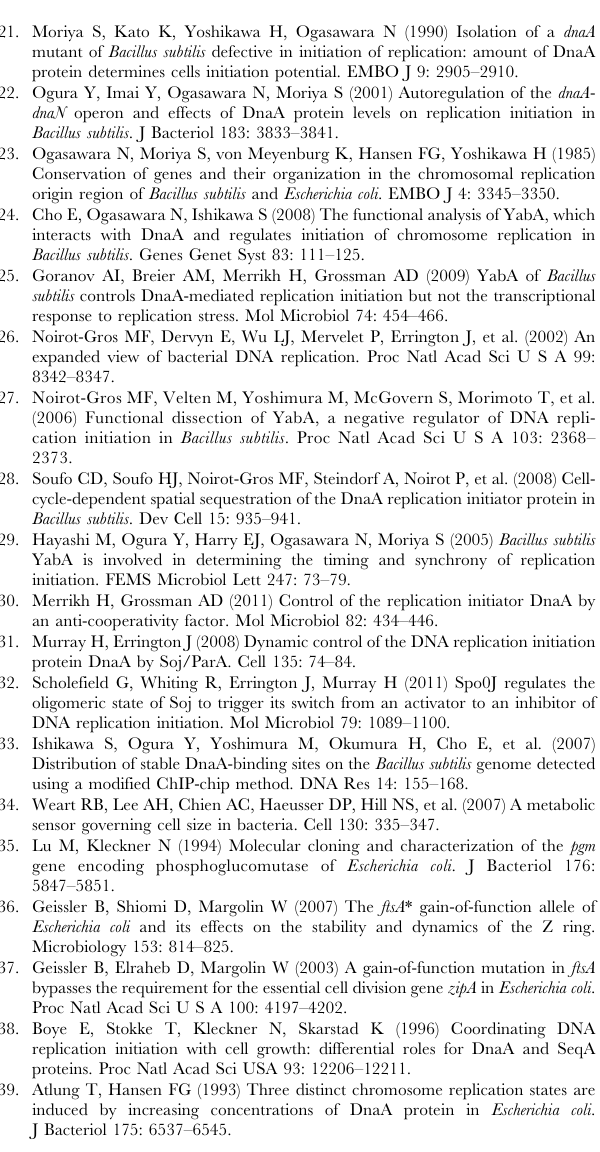
Figure S4 mRNA transcript levels of nrdAB were measured by qRT-PCR. Error bars equal one standard deviation (n= 3). Table S1 Bacterial strains and plasmids used in this study. Table S2 Oligonucleotide sequences used for RT-PCR. Table S3 Unaltered mutation rate despite faster replication in mutant E. coli